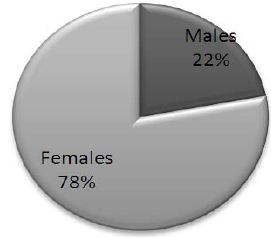
Fig. 1. Gender distribution of participants